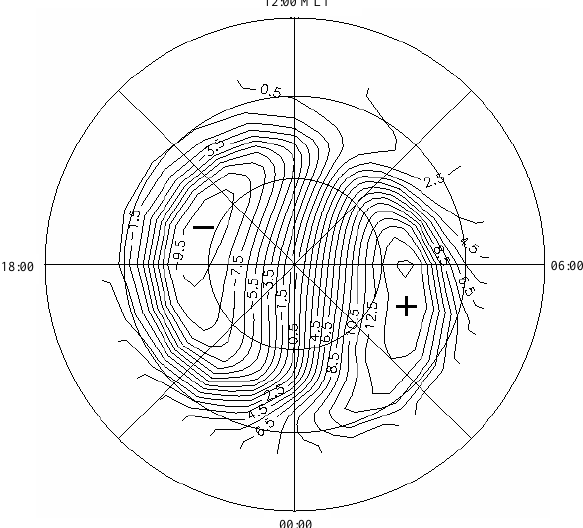
Fig. 4. Electric potential pattern used in the CTIP model to describe the high-latitude convection pattern. The latitude coverage of the plot is from 60 ◦ MLAT to 90 ◦ MLAT and the cross-polar potential is approximately 25kV.